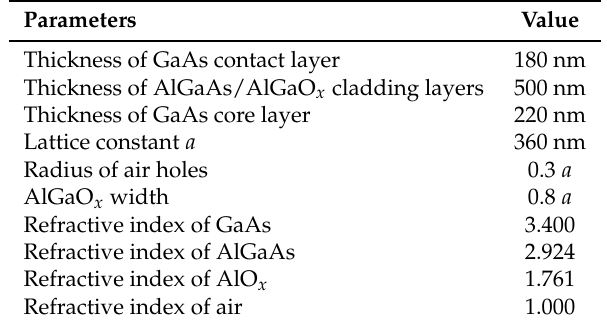
Table 1. Values of parameters used to construct 3D model of CirD lasers.